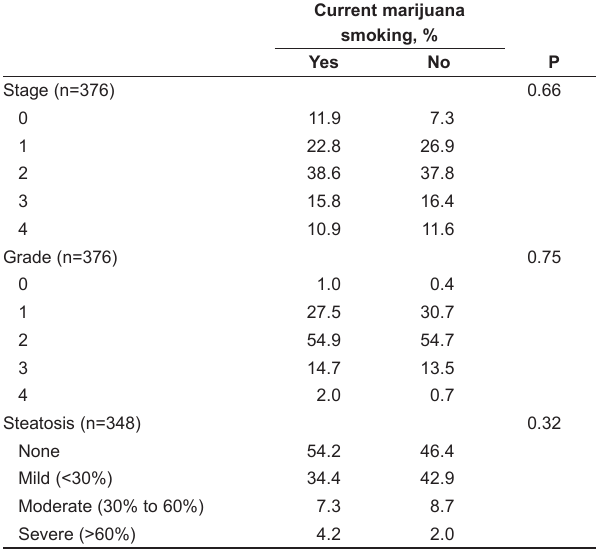
TAble 3 Hepatitis C virus (HCV) antiviral recipient characteristics as a function of marijuana smoking status at the time